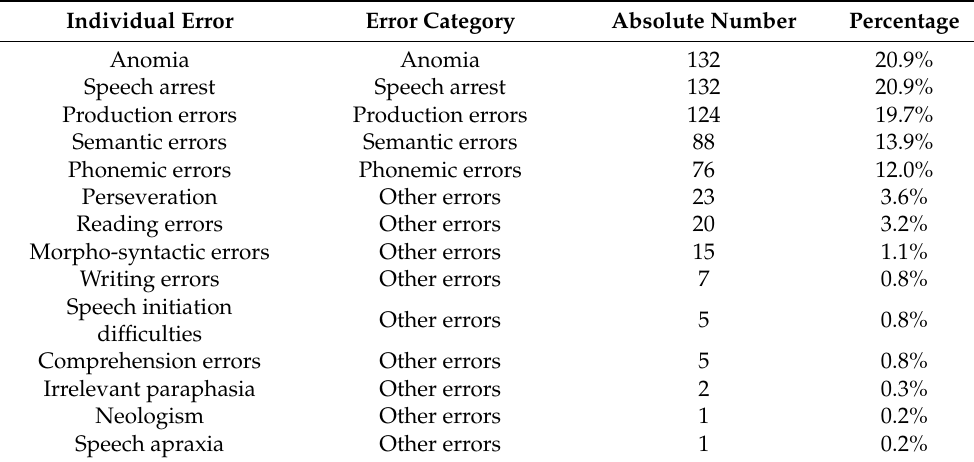
Table 4. The occurrence of different intraoperative speech and language errors in absolute numbers and percentages, ranked by frequency ( n =